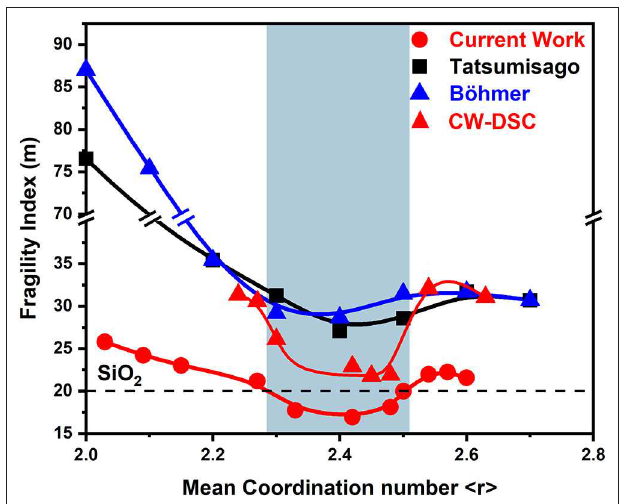
FIGURE 11 | Variations in the fragility index of equimolar Ge x As x Se 100 − 2x ternary melts reported by Tatsumisago et al. ( (cid:4) ) and by Böhmer and Angell ( N ) compared to those reported in the present work using MDSC ( • ) and DSC ( N